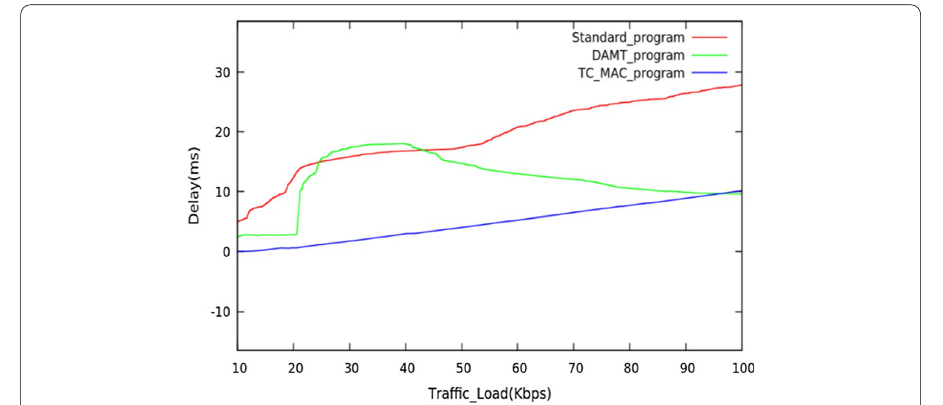
Fig. 11 End-to-end delay